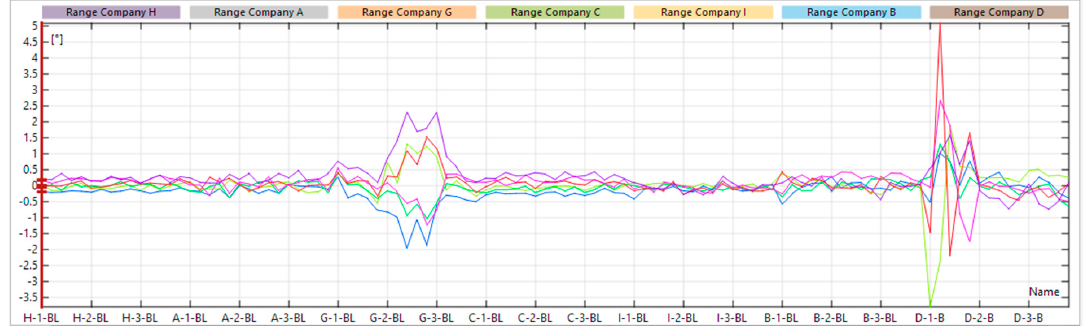
Figure 23. Deviation graph of pyramid inclination measurements compared to the nominal CAD dimensions produced with GOM Inspect for each pyramid from each company (in the graph, company F is referred as company I).